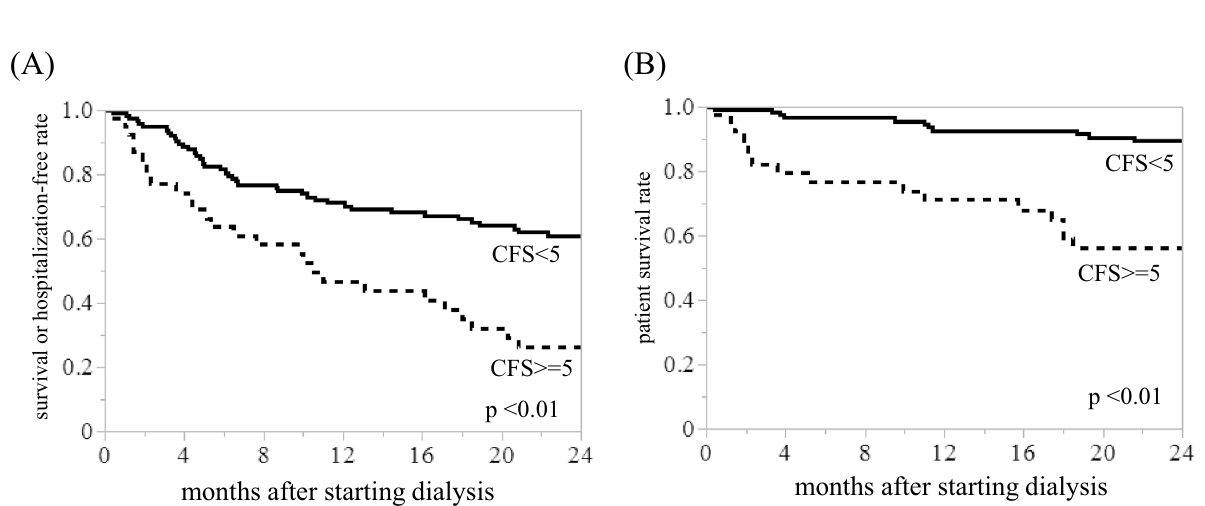
Figure 3. Kaplan–Meier analysis for the 2-year survival rate or probability of avoidance of the rehospitalization within 2 years after initiating dialysis. Composite outcomes of the survival rate or probability of avoidance of the rehospitalization ( A ) and survival rate ( B ) during 2 years from initiation of dialysis were significantly lower in the CFS ≥ 5 group than in the CFS < 5 group ( p < 0.01,